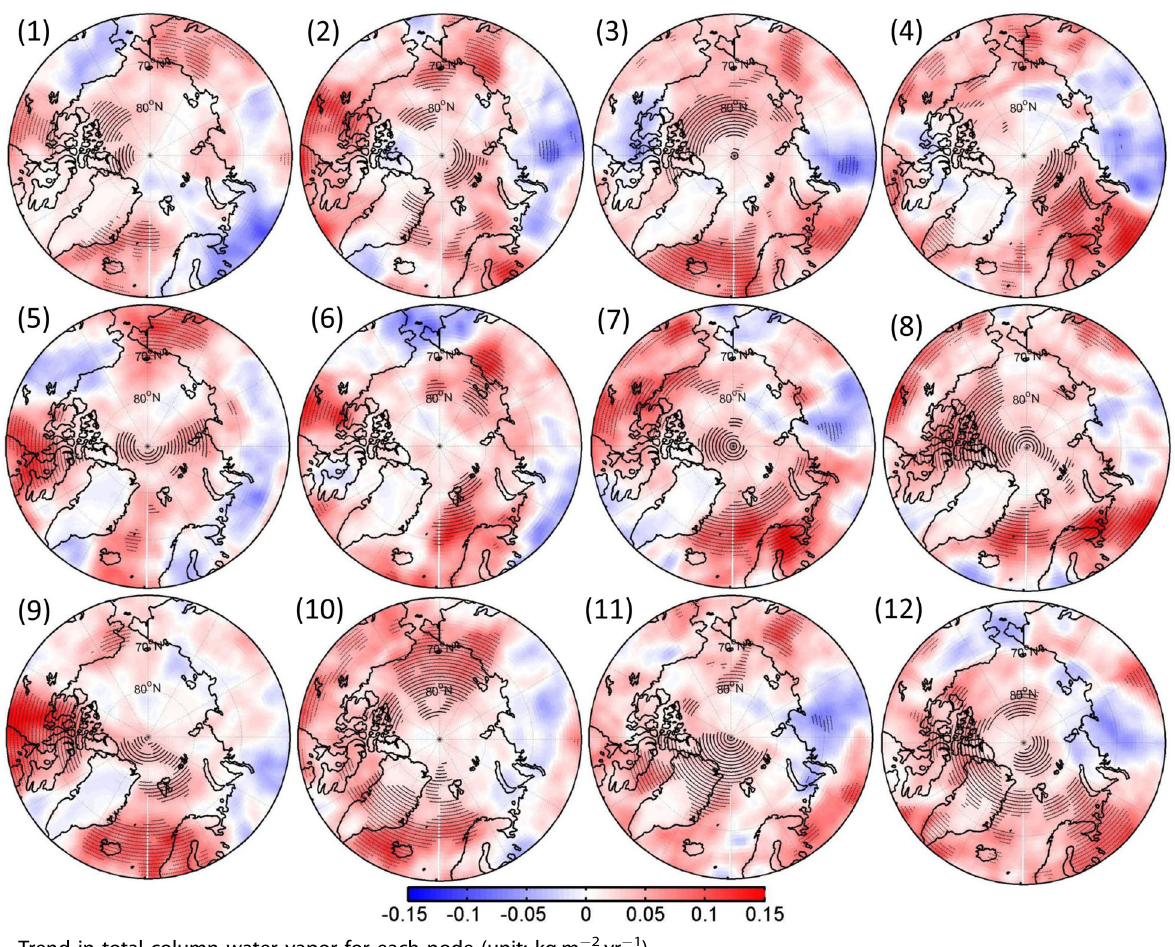
Fig. 12 Trend in total column water vapor for each node (unit: kg m − 2 yr − 1 ).